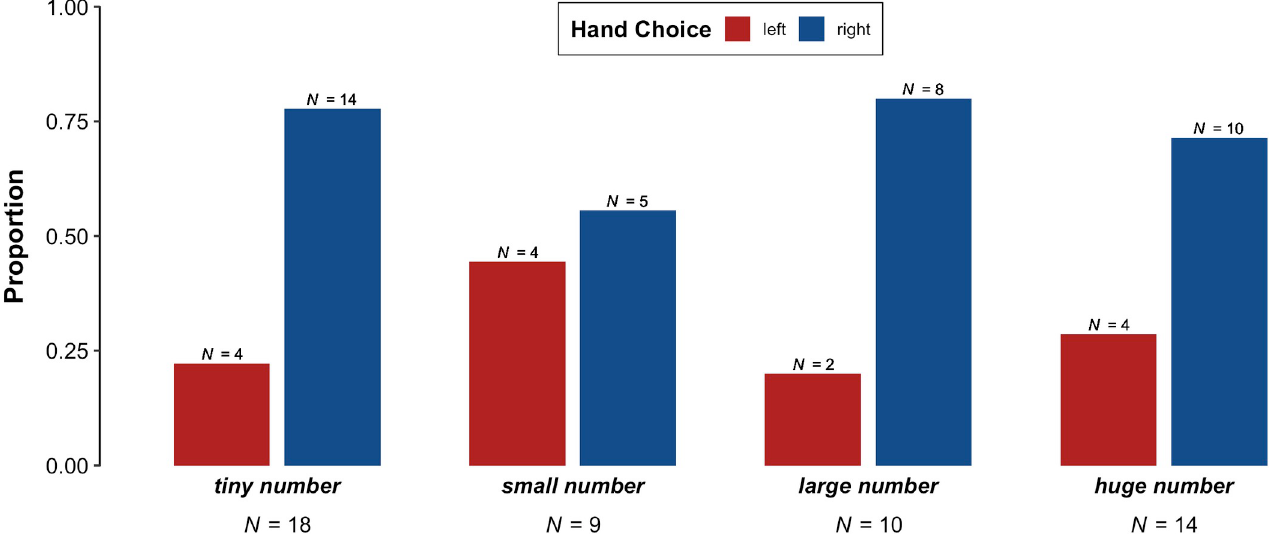
Fig 7. Proportion of videos in which both speakers’ hands were visible and free to gesture per phrase (’tiny number’, ’small number’, ’large number’, ’huge number’) that contained left-handed versus right-handed gestures.